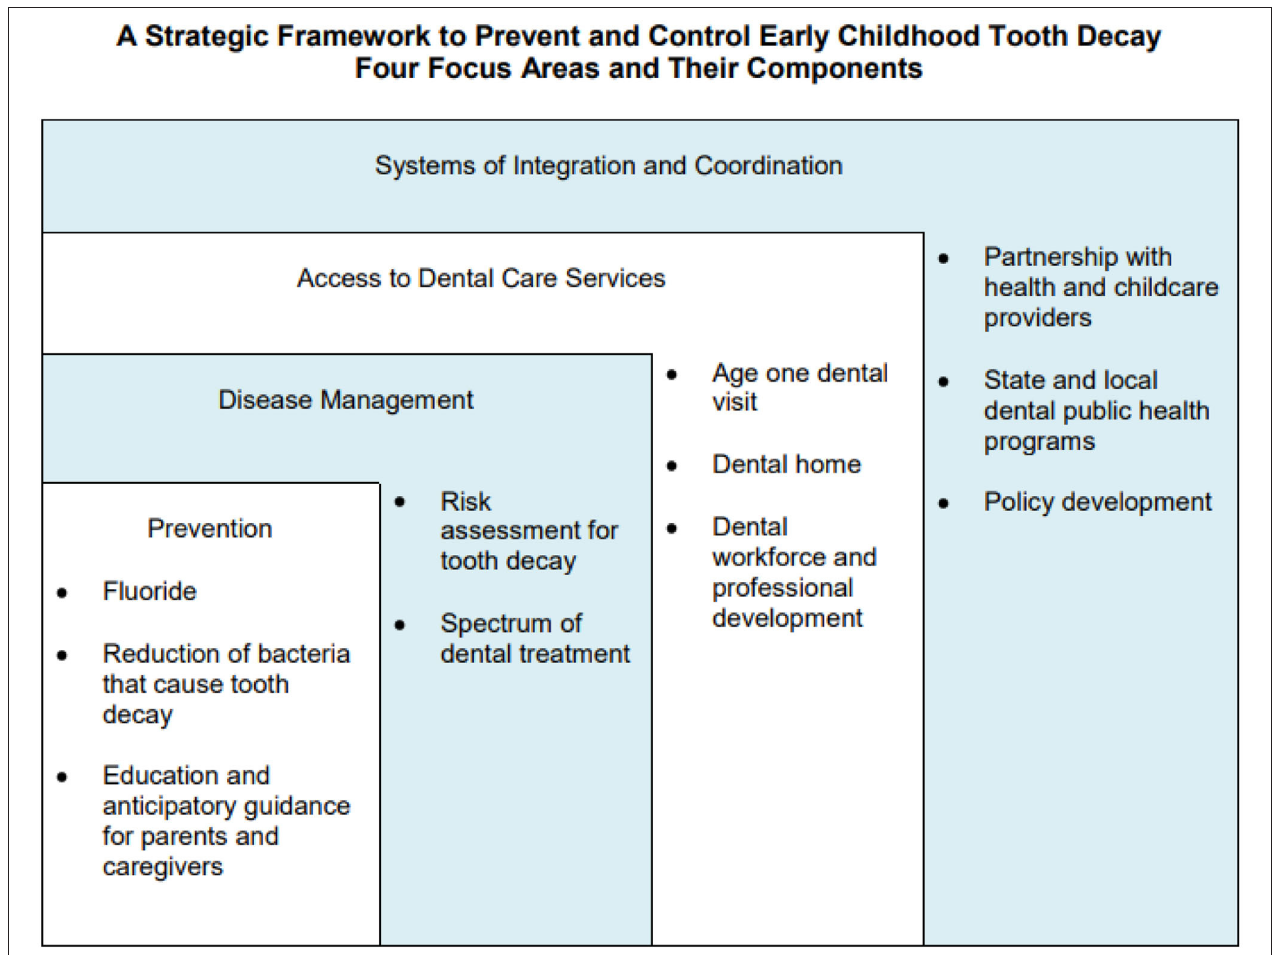
FIGURE 3 | A strategic framework to improve